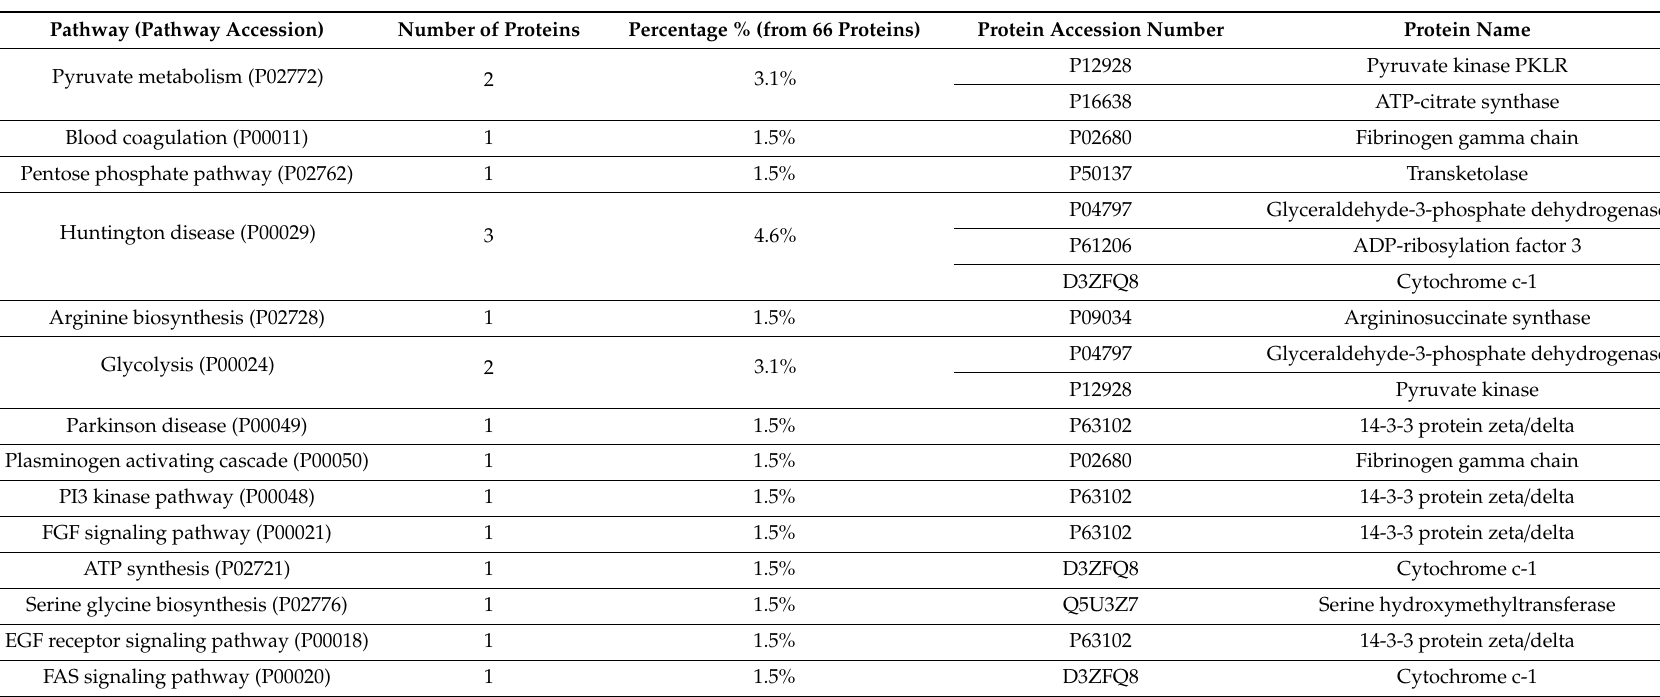
Table 1. List of signaling pathways involved in the response to IONPs at the liver level. The data were generated from PANTHER Classification